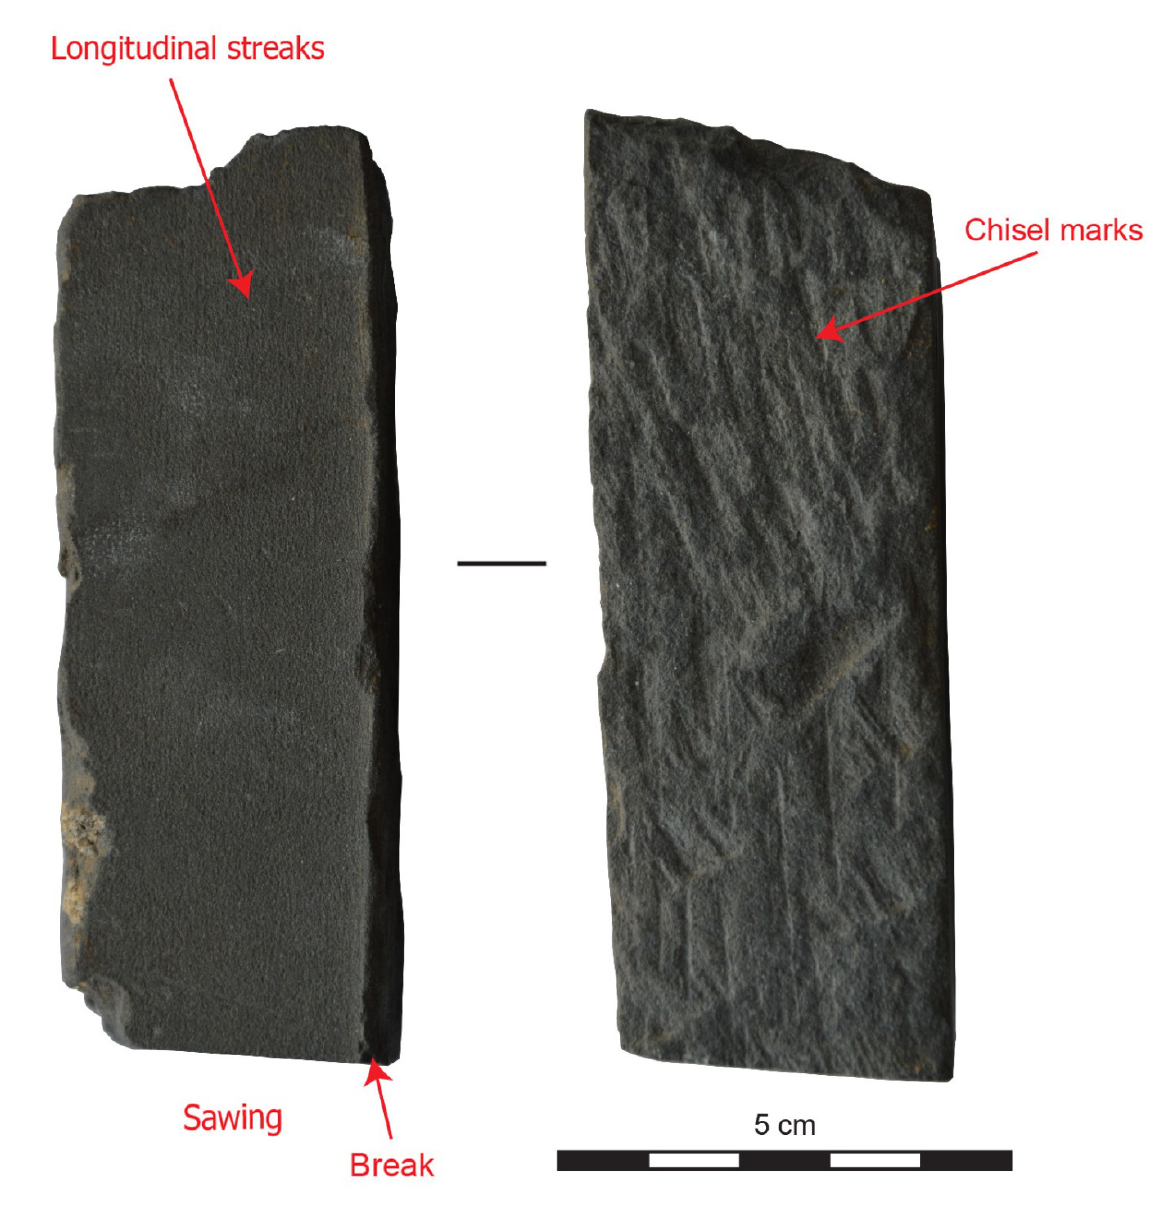
Figure 10: Parallelepiped bars cut from the slab with saw and chisel marks,